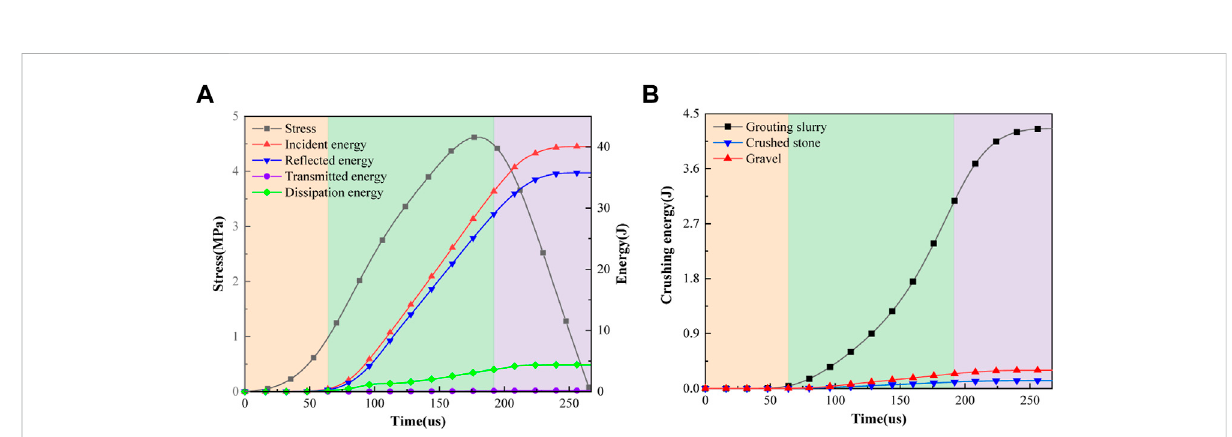
FIGURE 11 Energy curve of the grouting specimen. (A) Energy dissipation curve of the specimen, (B) Breakup energy curves of each